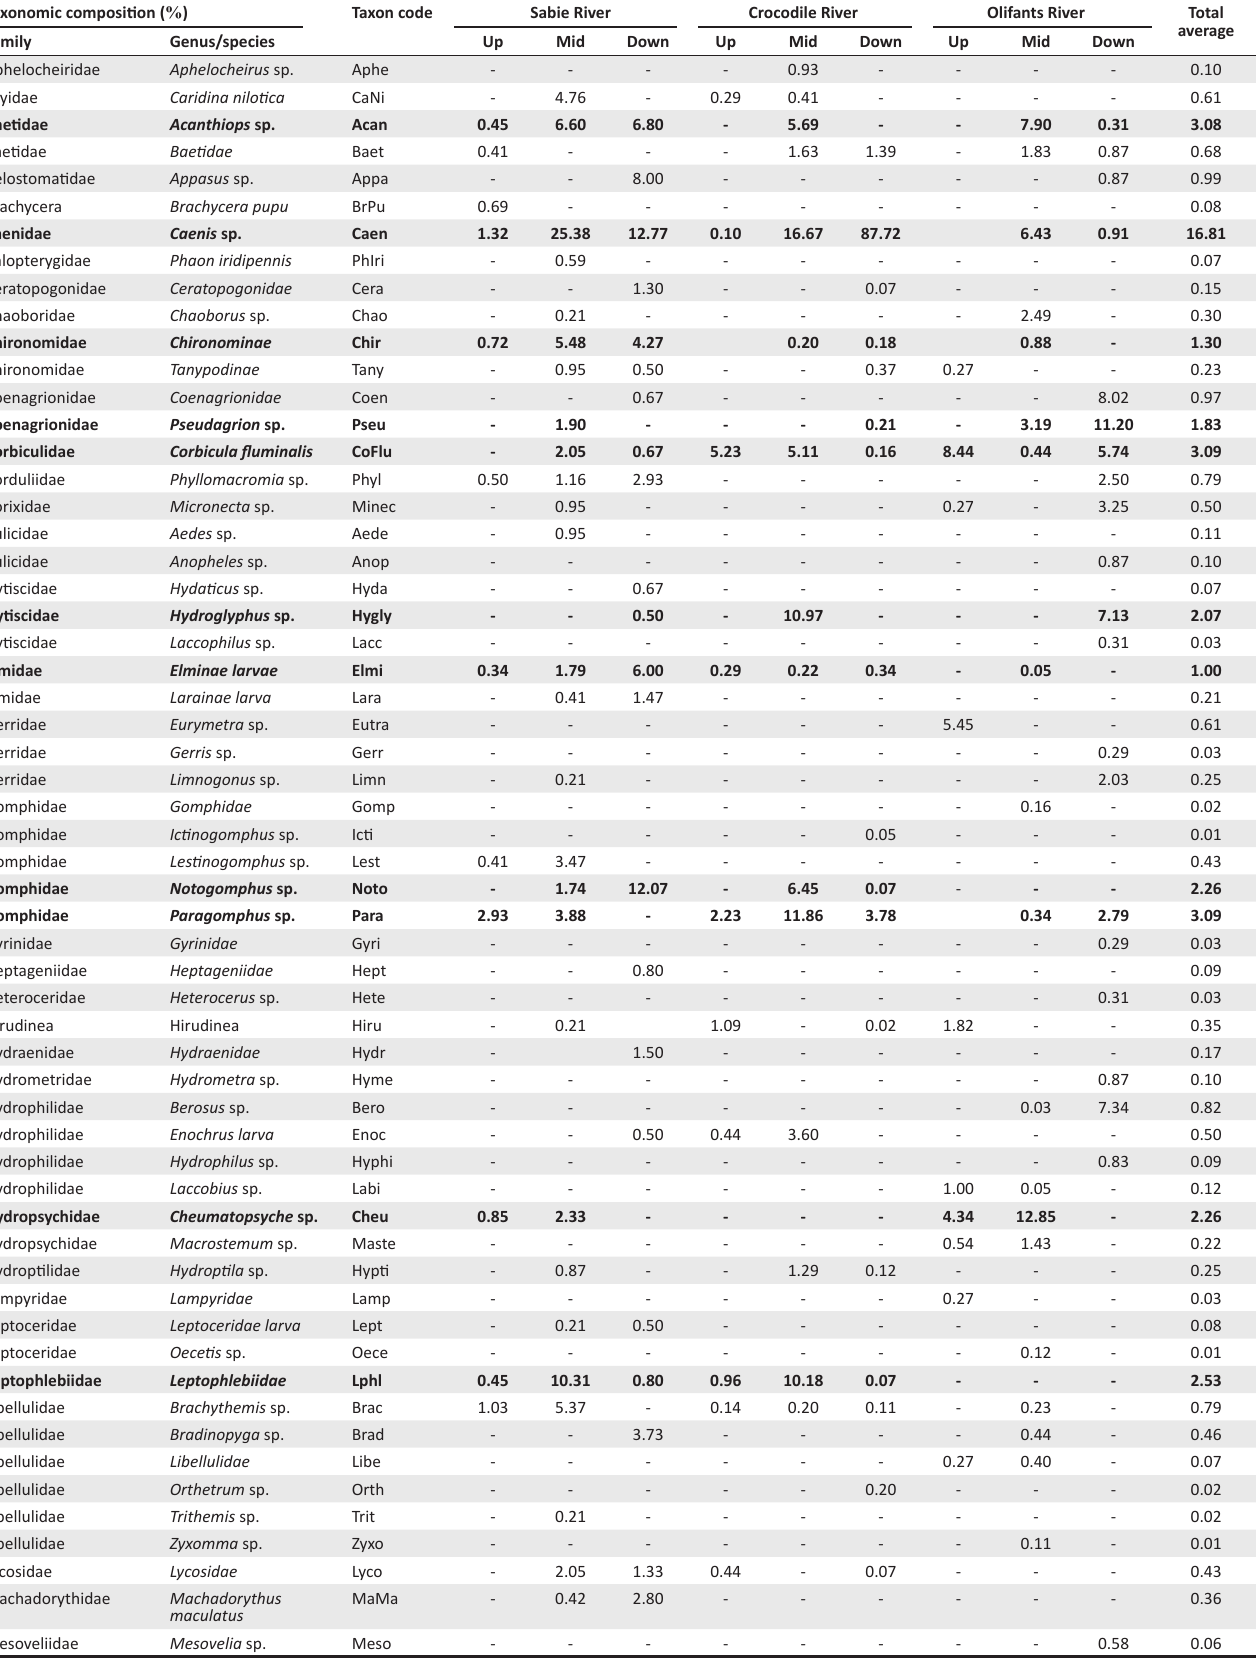
TABLE 1-A1: Relative taxonomic composition of the macrobenthic invertebrate community dwelling the riverbed of three rivers flowing through the Kruger National Park. Taxonomic composition ( %